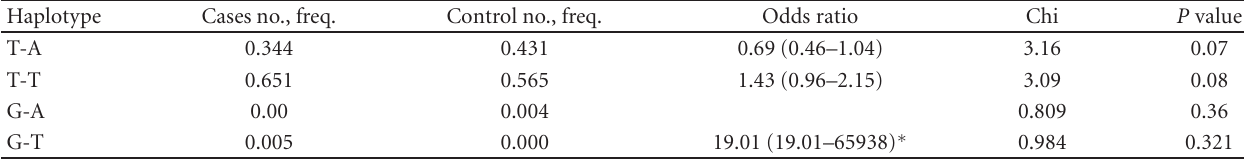
Table 3: Basic haplotypes of SNP1 and SNP3 at BMP2 gene in men with osteoporosis and controls. Haplotype